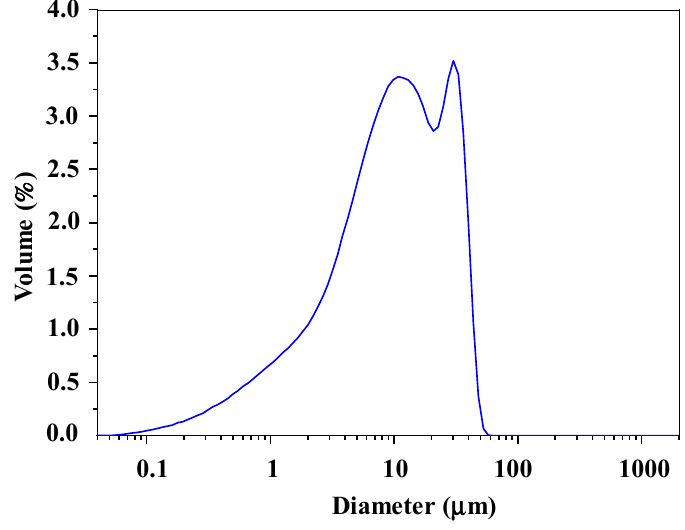
Figure 3. Particle size distribution of the CSP after milling used as raw material.